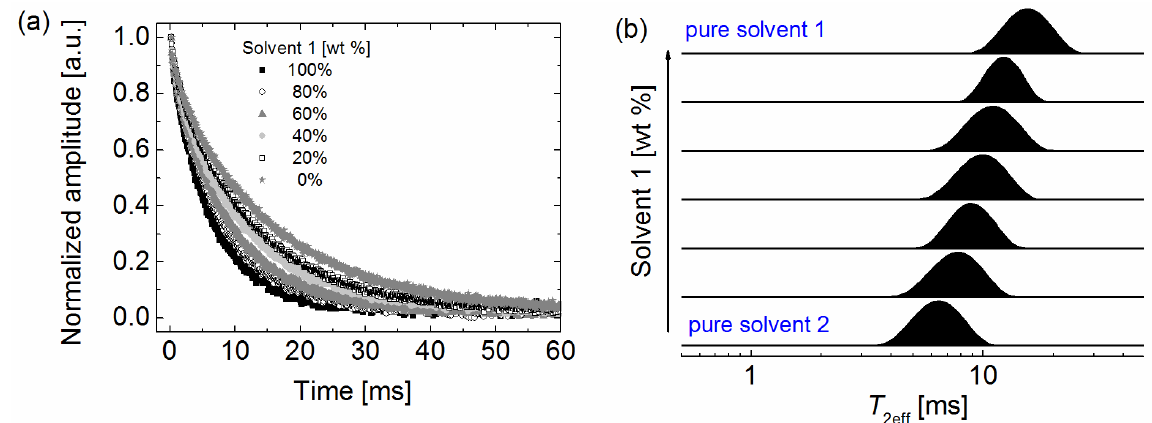
Figure 1. ( a ) Typical 1 H CPMG NMR decays of two pure solvents and their mixtures at different mass ratios. The CPMG decays were recorded at room temperature. ( b ) The corresponding ILTs of the CPMG decays depicted in ( a ). The amplitudes are normalized to unity.